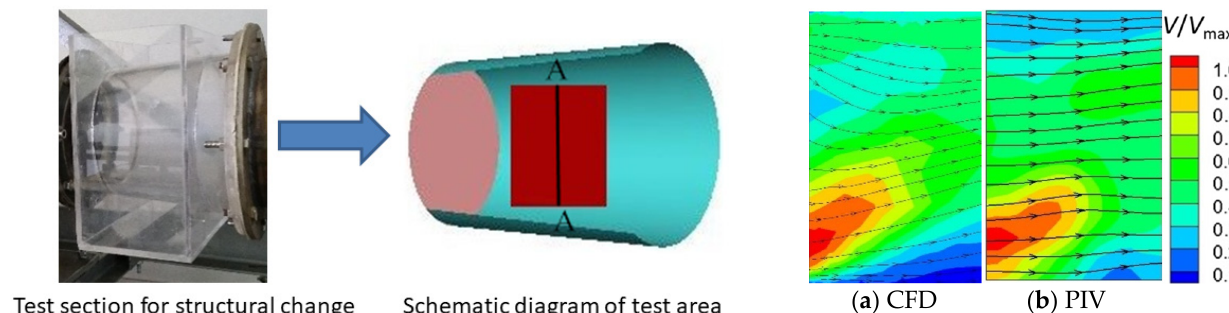
Figure 8. Comparison of velocity nephogram between CFD and 2D2C-PIV test.